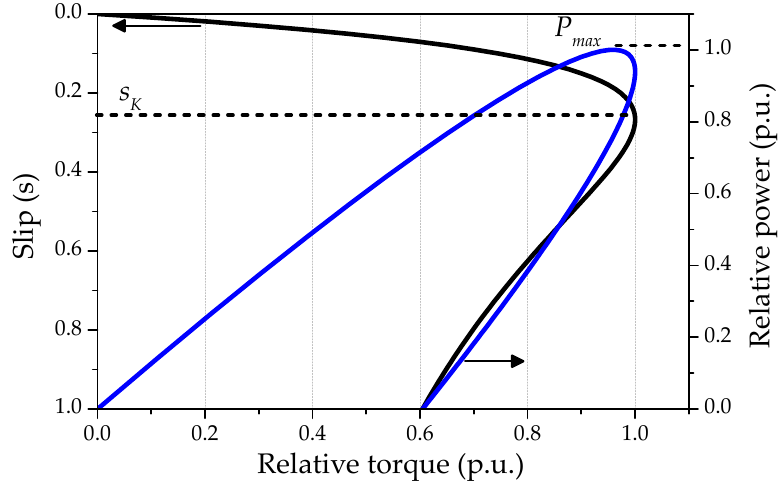
Figure 4. Typical velocity slip and motor power curves vs. loading torque.